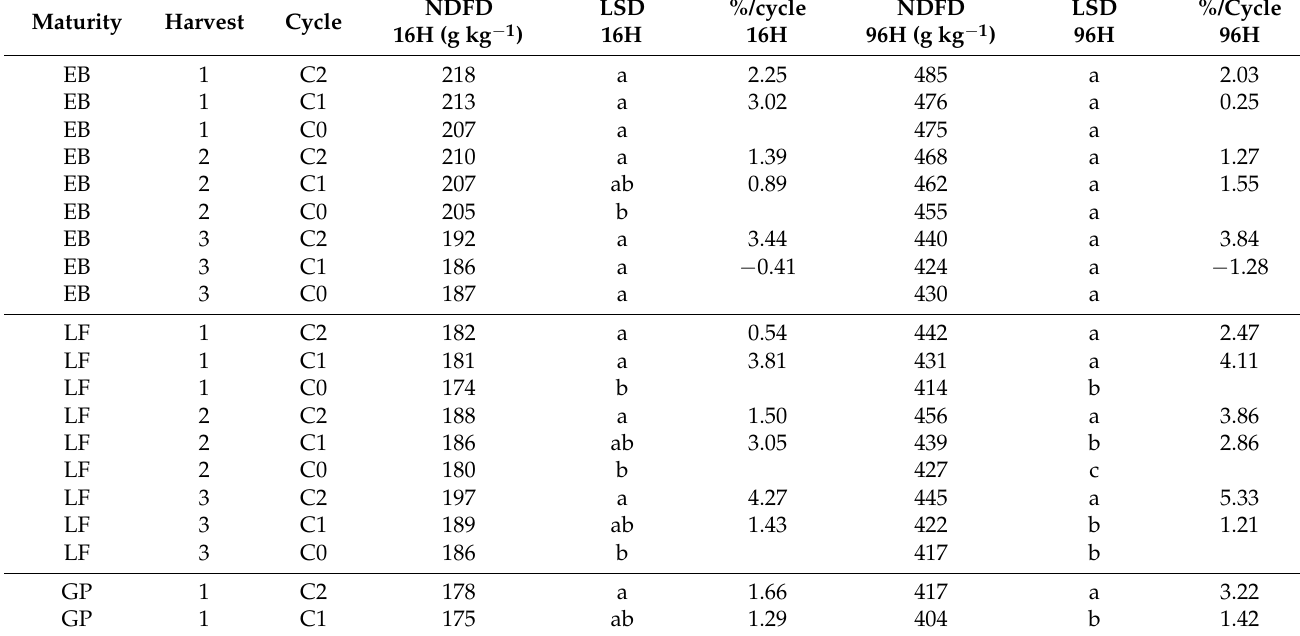
Table 4. Responses in 16 h and 96 h NDFD in the H16 × H96 populations with cycles of selection at the early bud (EB), late flowering (LF), and green pod (GP) maturity stages over three harvests. LSD is Fisher’s least significant difference test with different letters within a maturity stage indicating a significant difference; %/cycle is the percent change from C0 to C1 and C1 to